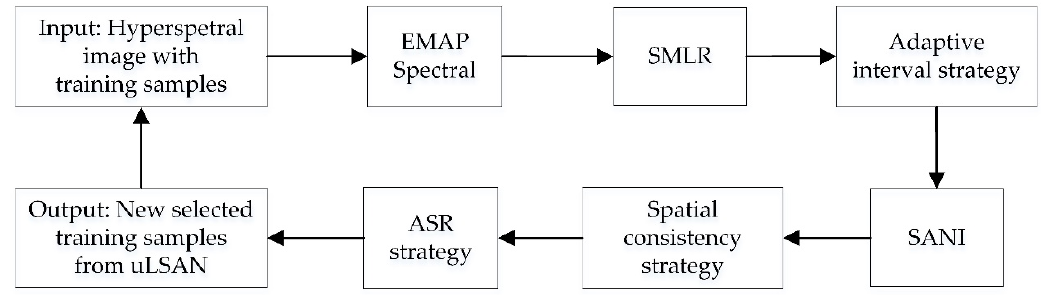
Figure 4. Flowchart for the selection of unlabeled samples from unlabeled samples’ SA neighborhood (uLSAN).